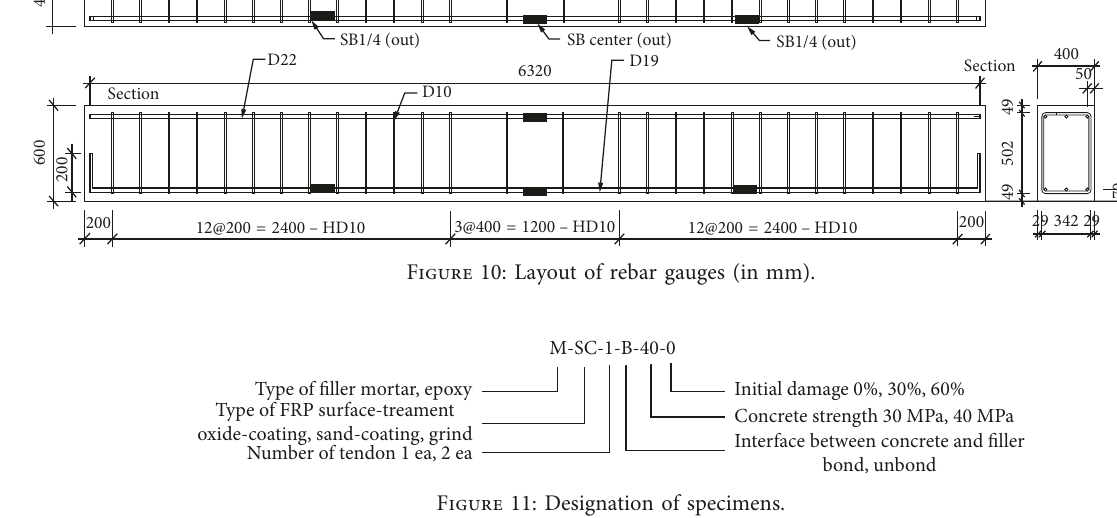
Figure 11: Designation of specimens.